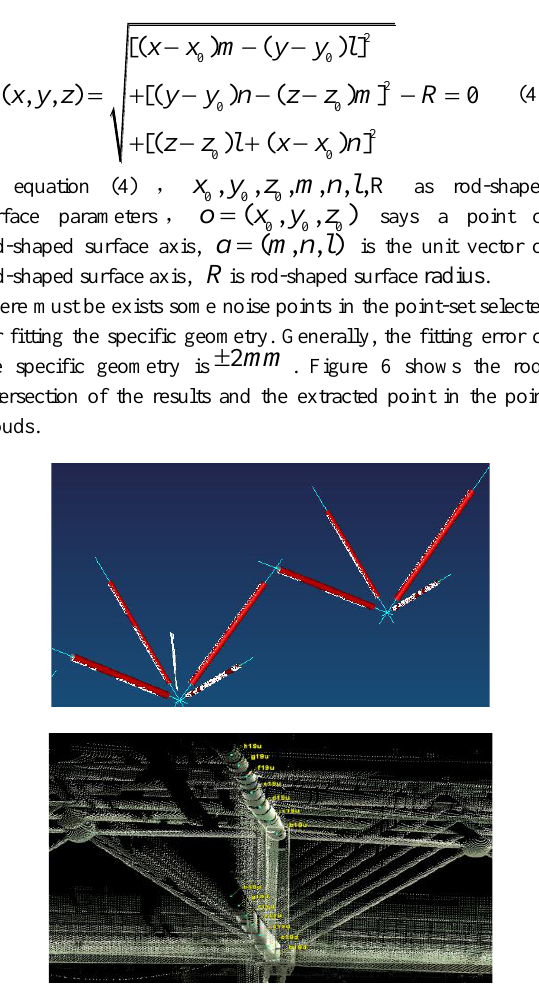
Figure 6 Rod-Shaped Components and its fitting